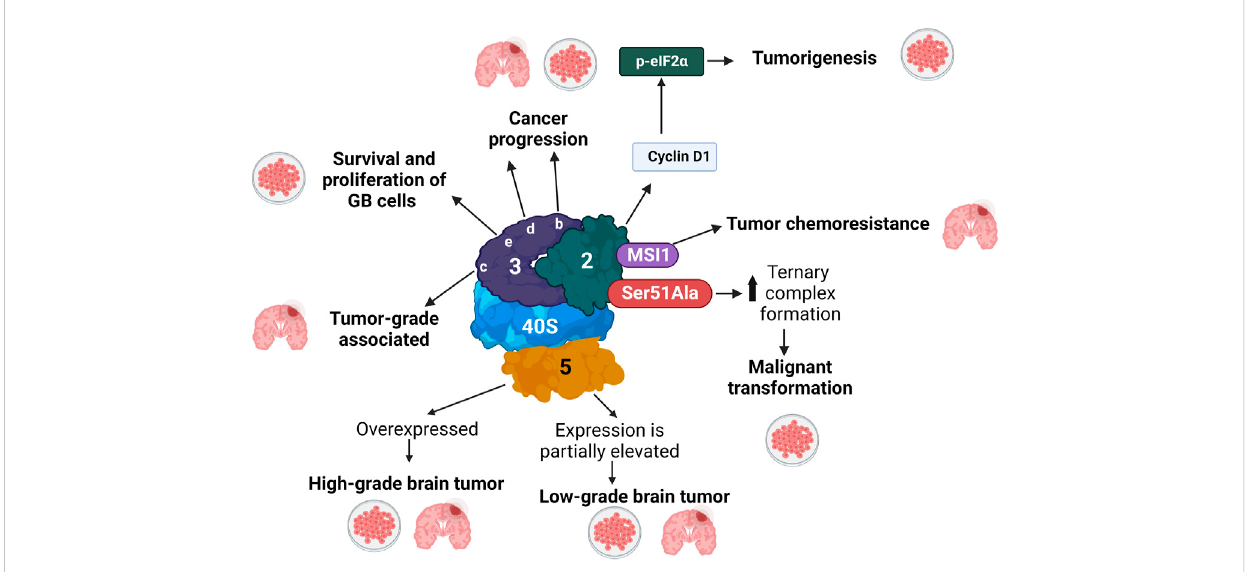
FIGURE 3 eIFs components of the 43S PIC involved in GB progression. eIFs are shown only with the respective numbers in complex with the 40S ribosomal subunit. Thick arrows indicate overexpression (upward) or downregulation (downward). Thin arrows indicate what GB process eIFs are involved in. The different phenomena observed in patients and in cultured cells, are indicated with a Petri dish and a brain , respectively.